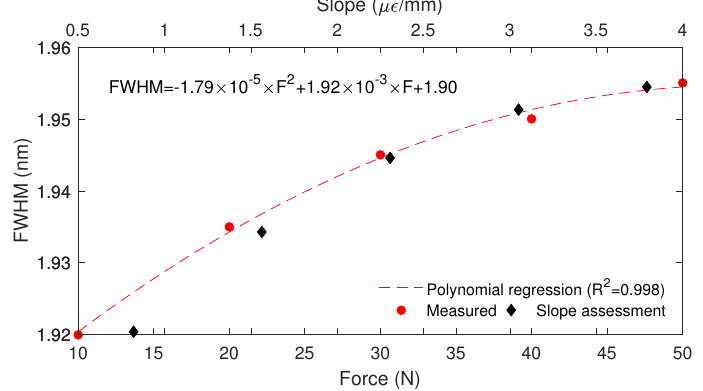
Figure 11. FWHM as a function of the force applied to the beam.